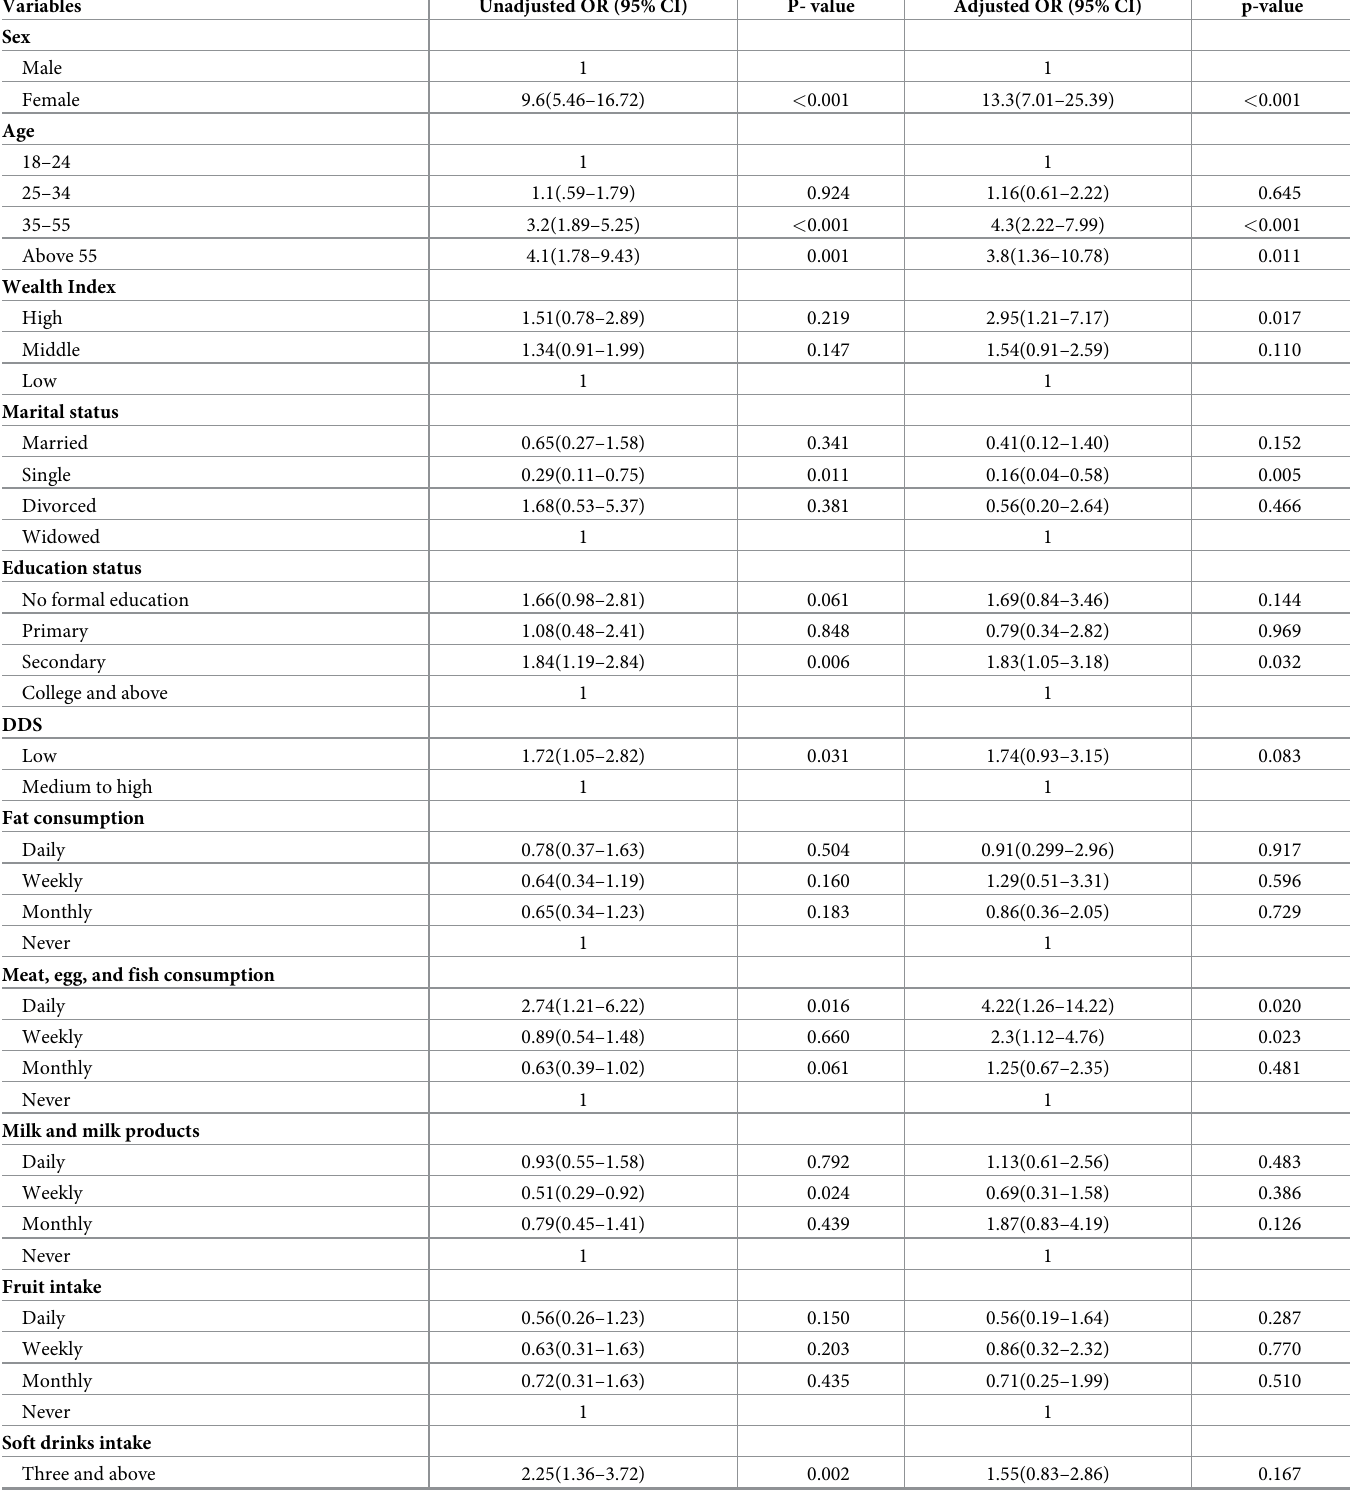
Table 4. Risk factors of abdominal obesity among adult population in Woldia town, Northeast Ethiopia,